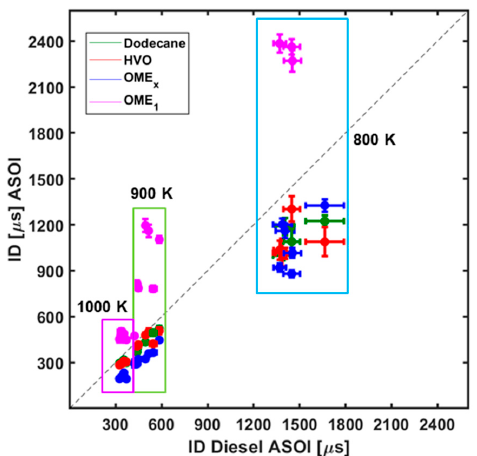
Figure 6. Comparison between ignition delay of diesel and the ignition delay for the other fuels tested.